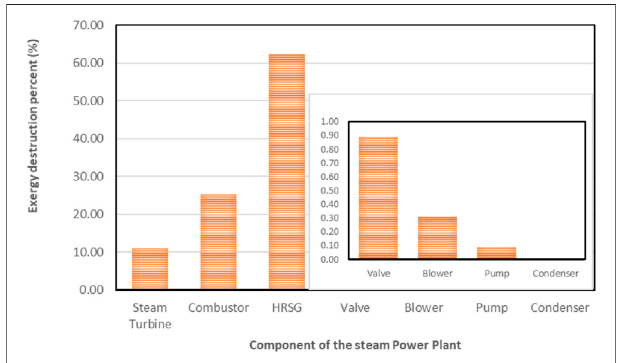
FIGURE 11 | Exergy destruction percent for the components in steam power plant process.